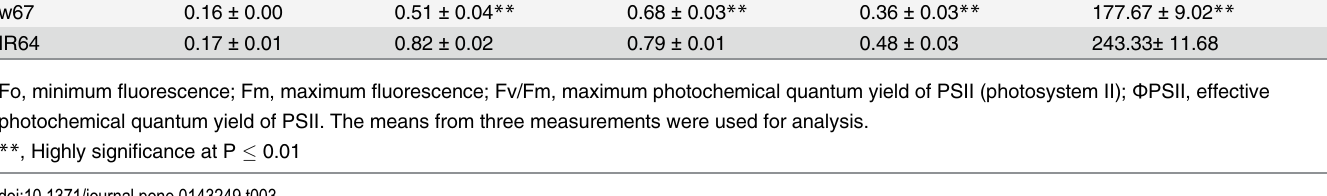
Table 3. Chlorophyll fluorescence parameters in the 11-week-old w67 mutant and wild-type IR64. Material